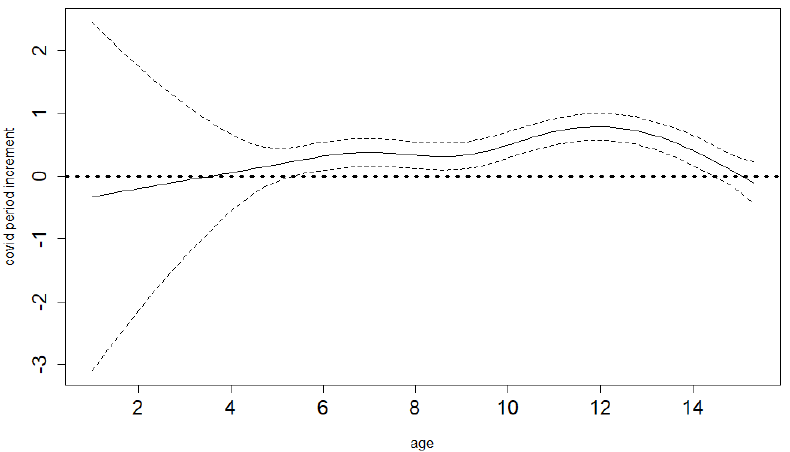
Figure 5. Differential COVID-19 year effect for different ages for boys, estimated smooth trend (solid line) and pointwise 95% confidence interval limits (dotted lines). Age in years.